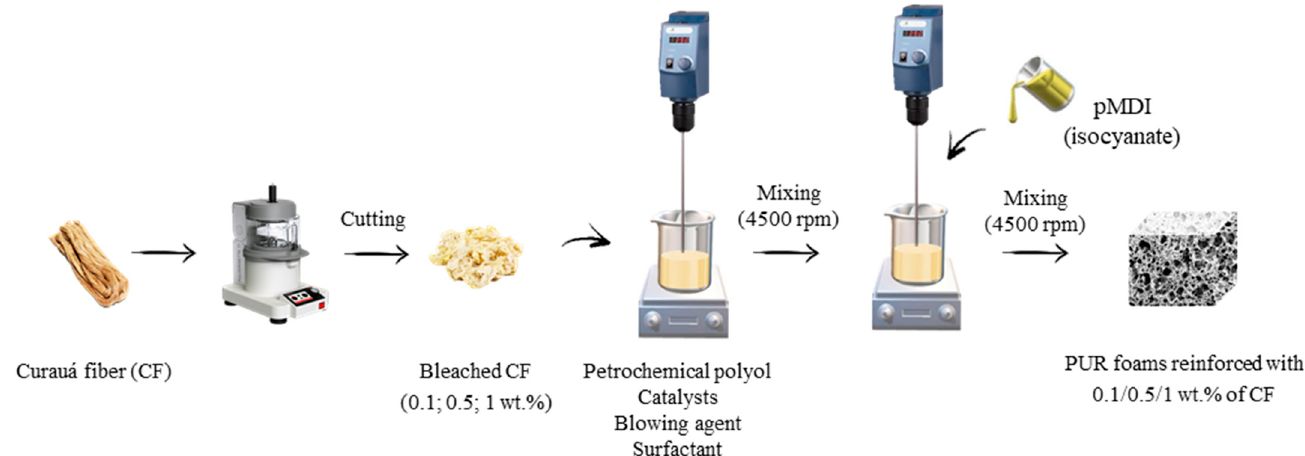
Figure 10. Flowchart for the manufacturing of rigid polyurethane foam composites. Filled pre-polyol systems’ viscosities were evaluated using a Viscometer DVII+ (Brook- field, Dresden, Germany) in the function of a shear rate, according to ISO 2555